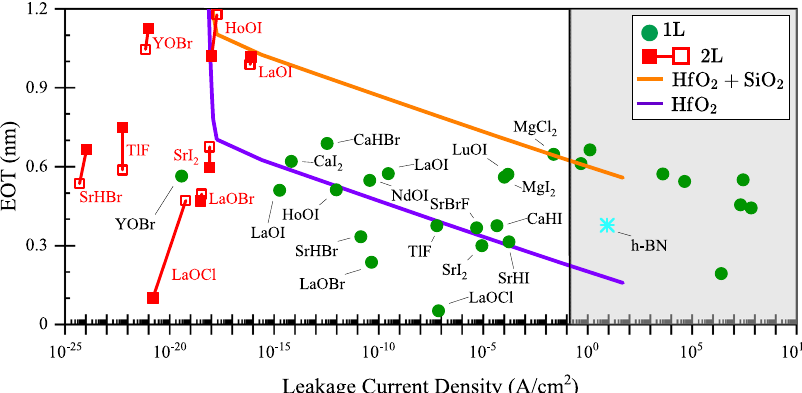
Fig. 4 Leakage current and EOT for monolayers (green circles) and bilayers (red squares) in n -MOS applications. Reference dielectrics are also shown: The blue star shows monolayer h-BN. The dark purple line shows the EOT corresponding to the different thicknesses of HfO 2 (between 1 and 10 nm), while the orange line represents 0.4 nm of interfacial SiO 2 in addition to HfO 2 . The shaded light gray area shows values that fall outside of the IRDS leakage current (per pitch) criterion of 100 pA/ µ m for a transistor with a 28 nm pitch, an 18 nm long gate, and an effective gate width of 107 nm 58 . The acceptable current density becomes 0.145 A/cm 2 . For the bilayer, we estimate the performance using the dielectric constant of monolayer ( fi lled squares) and using the bulk dielectric constant (hollow